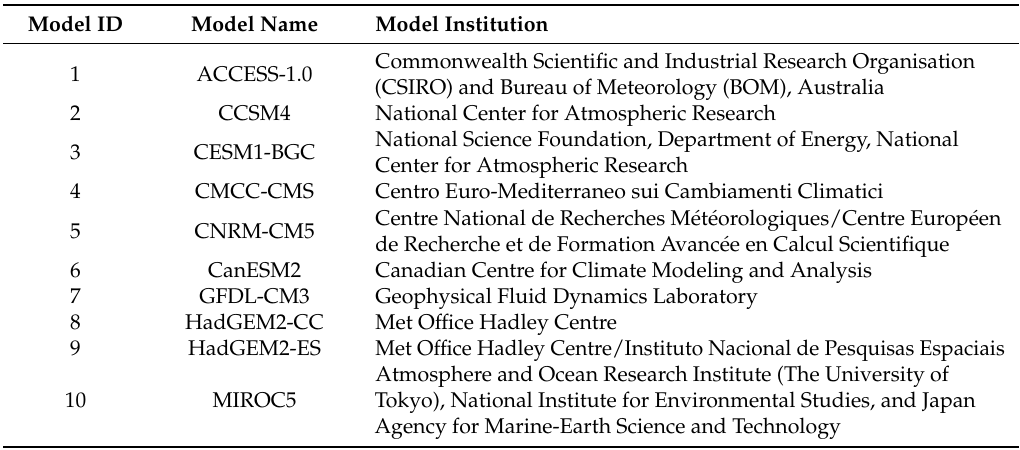
Figure 2. Long-term (1951–2013) mean monthly precipitation ( a ) and temperature ( b ) of 10 hydrologic regions. Table 2. GCMs Selected for California Water Resources Planning 1